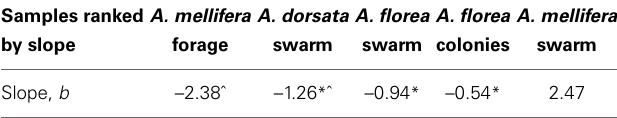
Data sets that share a symbol have statistically equivalent slopes (e.g., show the same relationship between angular deviation and mean waggle phase duration). See Table 4 for details of the statistics.